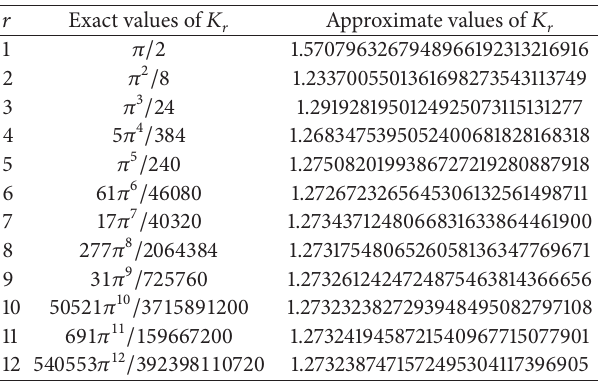
Table 1: Exact and approximate values of the Favard constants 𝐾 𝑟 , calculated by the recursive formulas (7a) and (7b) using Mathemat- ica software